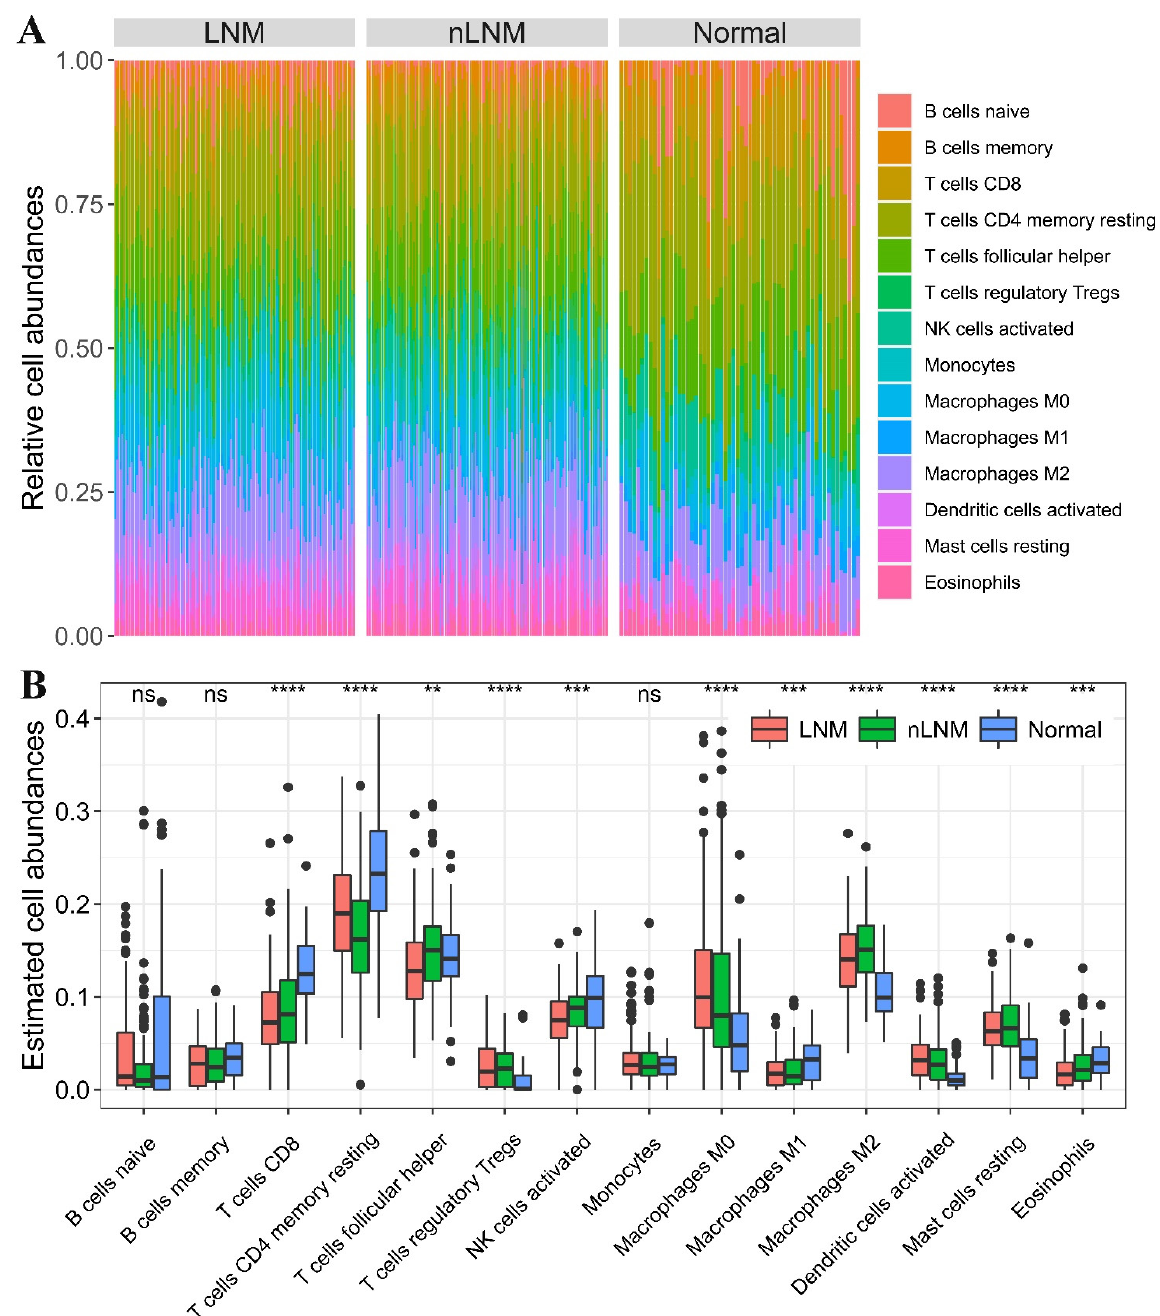
Figure 2. Tumor-infiltrating immune cell abundances in PTC. ( A ) Measurement of immune cell abundances in different PTC groups using CIBERSORTx. Eight immune cell subtypes with a median abundance close to zero were excluded from subsequent comparisons. ( B ) Comparison of infiltrating immune cells between different PTC groups. Differences in immune cell abundance between three PTC groups were assessed by the Kruskal–Wallis rank-sum test. ns: p > 0.05, **: p ≤ 0.01, ***: p ≤ 0.001, ****: p ≤ 0.0001. LNM and nLNM represent PTC with and without LNM, respectively. ‘Normal’ represents normal thyroid tissue adjacent to the PTC tumor. The average abundance of each type of immune cell was then compared between different PTC groups (Figure 2B). As a result, 11 lymphocytes showed significantly differ- ent abundances between different PTC groups ( p < 0.05). Overall, the abundances of CD8